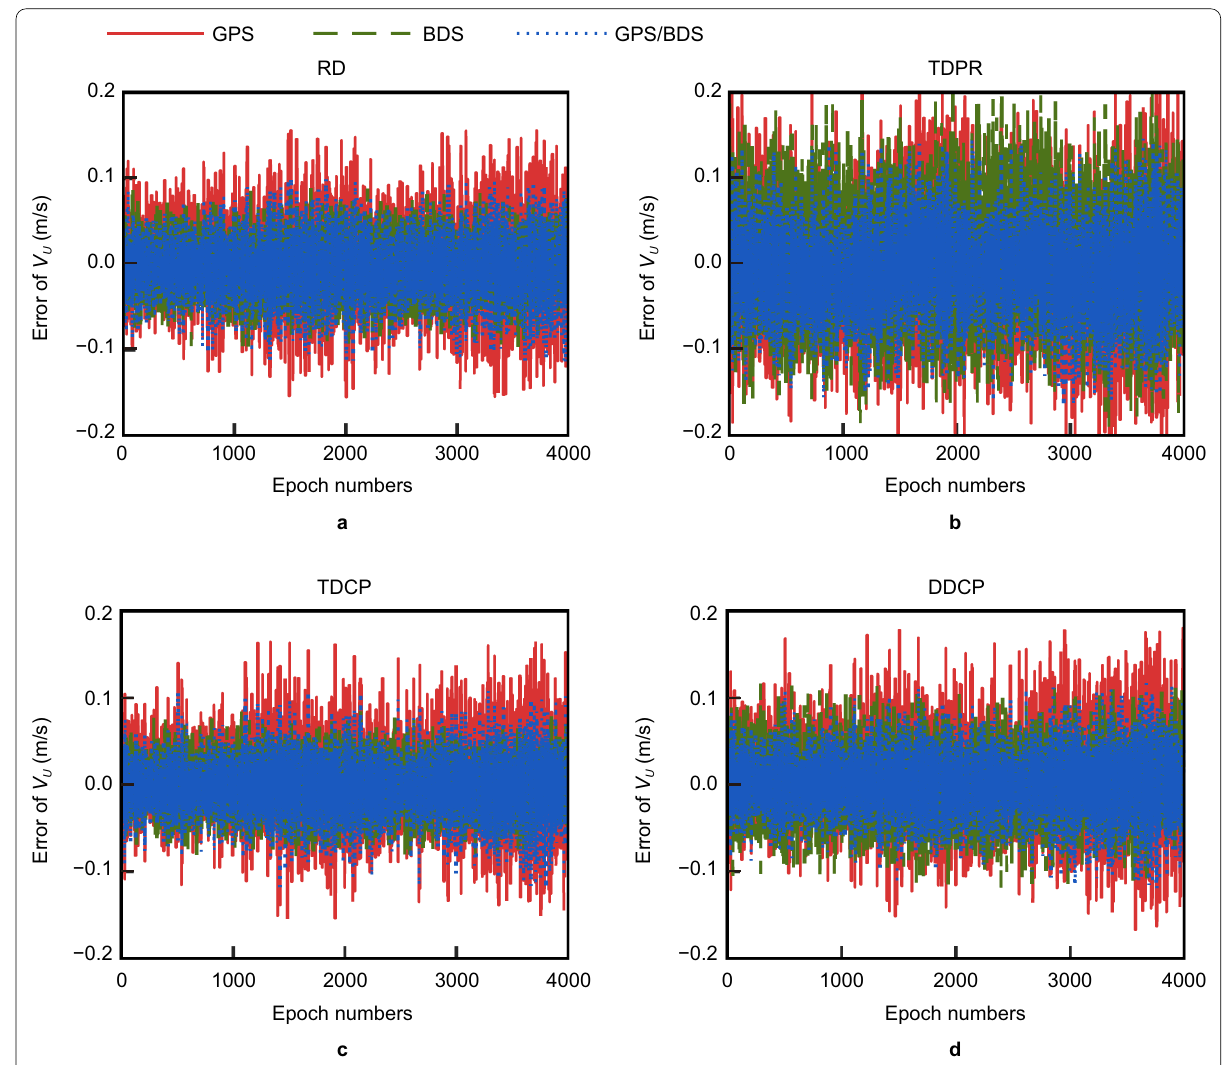
Fig. 3 Velocity determination results in up component with the RD- ( a ), TDPR- ( b ), TDCP- ( c ) and DDCP- ( d ) based methods in a static